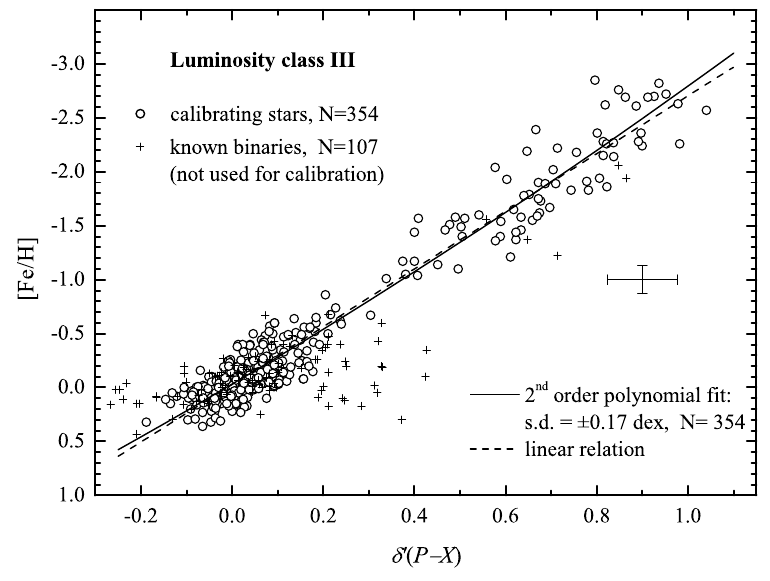
Fig. 7a. (cid:14) ′ ( P – X ) vs. [Fe/H] relation for calibrating giant stars with metallicities from high-dispersion spectroscopy. The solid line is a second-order polynomial fit and the dashed line is a linear relation. Known spectroscopic binaries are plotted for comparison.